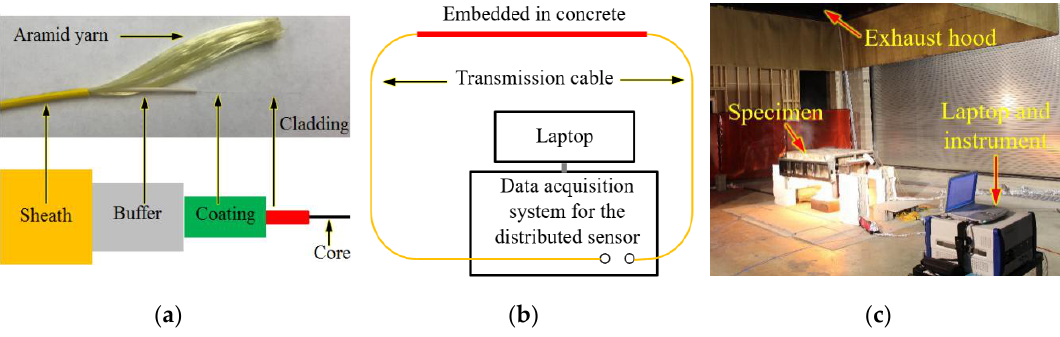
Figure 2. Distributed fiber optic sensor: ( a ) sensor structure, ( b ) schematic of measurement setup, and ( c ) photo of setup. A length of the fiber optic cable was embedded in the concrete slab of the specimen.